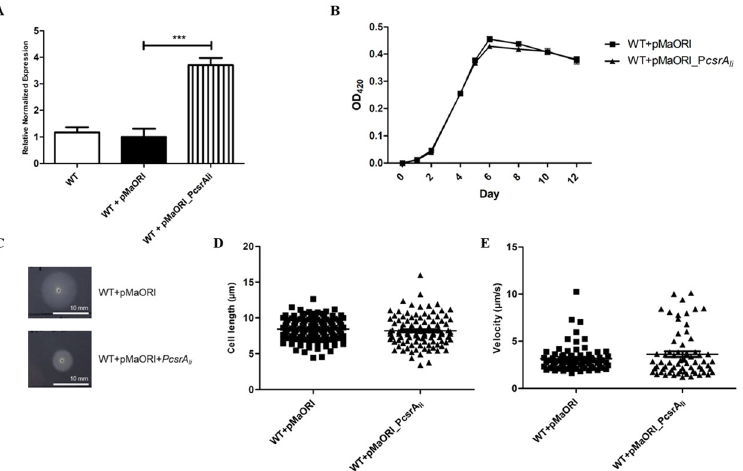
Fig 7. Overexpression of csrA in L . interrogans . (A) Overexpression of csrA in L . interrogans . To confirm overexpression of csrA , RNA was extracted from each Leptospira strain and then subjected to RT-qPCR. Results obtained from 3 independent cultures were presented as relative fold changes ± SEM. LipL32 was used for normalization. ( ��� ) indicates p-value < 0.001. (B) Growth curve of L . interrogans . The 2 × 10 6 cells of each bacterial strain were grown in 10 mL of regular EMJH. OD 420 measurement for growth was performed every 24 h. Results obtained from 3 independent experiments are expressed as Mean ± SEM. (C) Soft agar assay of L . interrogans . Leptospira at OD 420 = 0.1 were inoculated onto 0.6% semisolid EMJH plates and incubated at 30˚C. (D) Measurement of cell length of L . interrogans (E) Measurement of velocity of L . interrogans . Late exponential phase of Leptospira grown in EMJH medium were measured for cell length and velocity under a dark-field microscope using cellSens software (OLYMPUS).